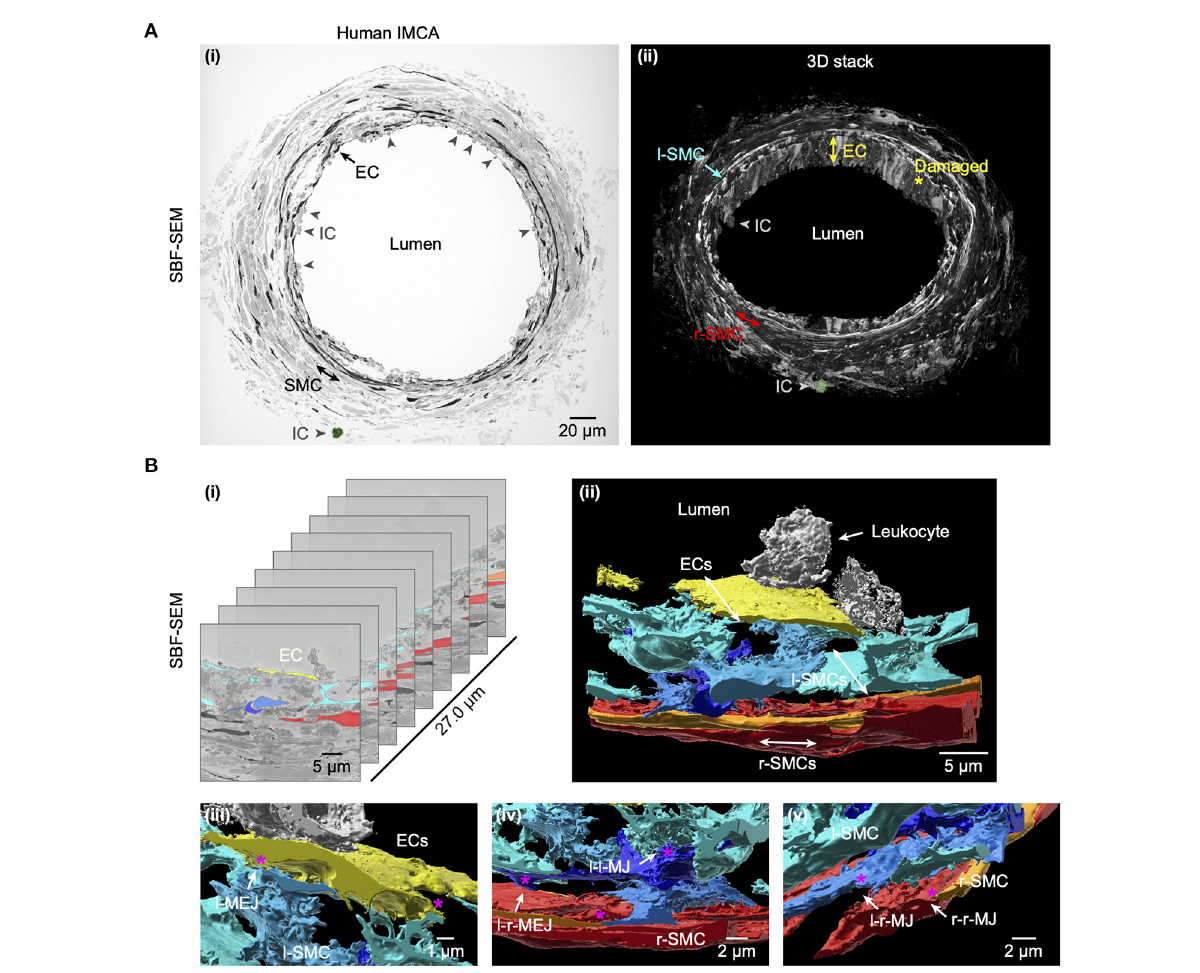
FIGURE11 Cell-cell contact sites in a human RA-IMCA with contractile dysfunction. The artery (Artery #3, Table 2) did not develop myogenic tone but was processed for serial block face scanning electron microscopy. At low resolution (A) it is clear that many ECs are damaged and inflammatory cells (ICs) have adhered to the artery wall, the same IC is highlighted in green in both the 2D- (left) and 3D- (right) images. A movie through the 3D z-stack at low and higher resolution is available at Dora et al. (18). (B) The cell-cell contact sites were visible in the SBF-SEM images. Individual cells were 3D rendered and are shown superimposed on the original images (i) and as the reconstructed artery walls (ii–v ; Supplementary Video 4). Multiple layers of interspersed longitudinally arranged SMCs (l-SMCs) are shown in blue (see also Figure 12), and circumferential radial SMCs (r-SMCs) in orange and red; each of which contacted each other and often adjacent endothelial cells. Examples are indicated by r-MEJ, r-SMC to EC junction; l-MEJ, l-SMC to EC junction; l-l-MJ, l-SMC to l-SMC junction; r-r-MJ, r-SMC to r-SMC